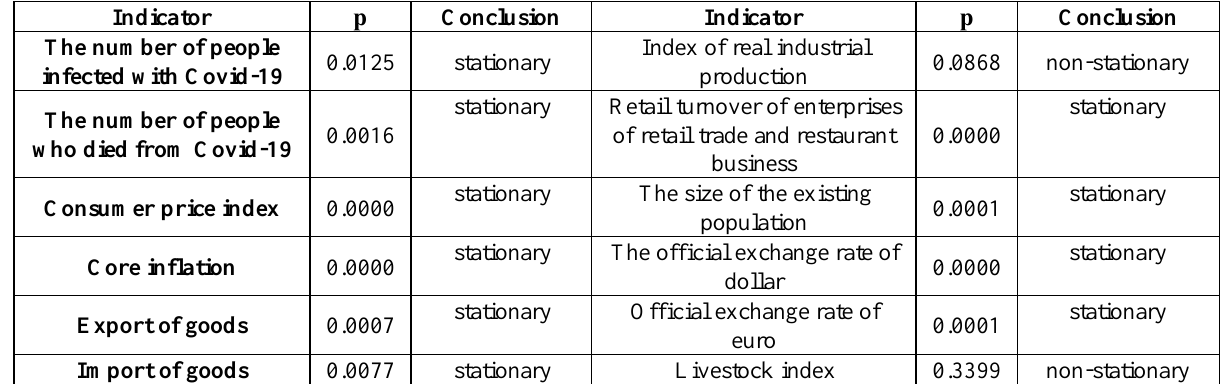
Table 1. Results of testing time series for